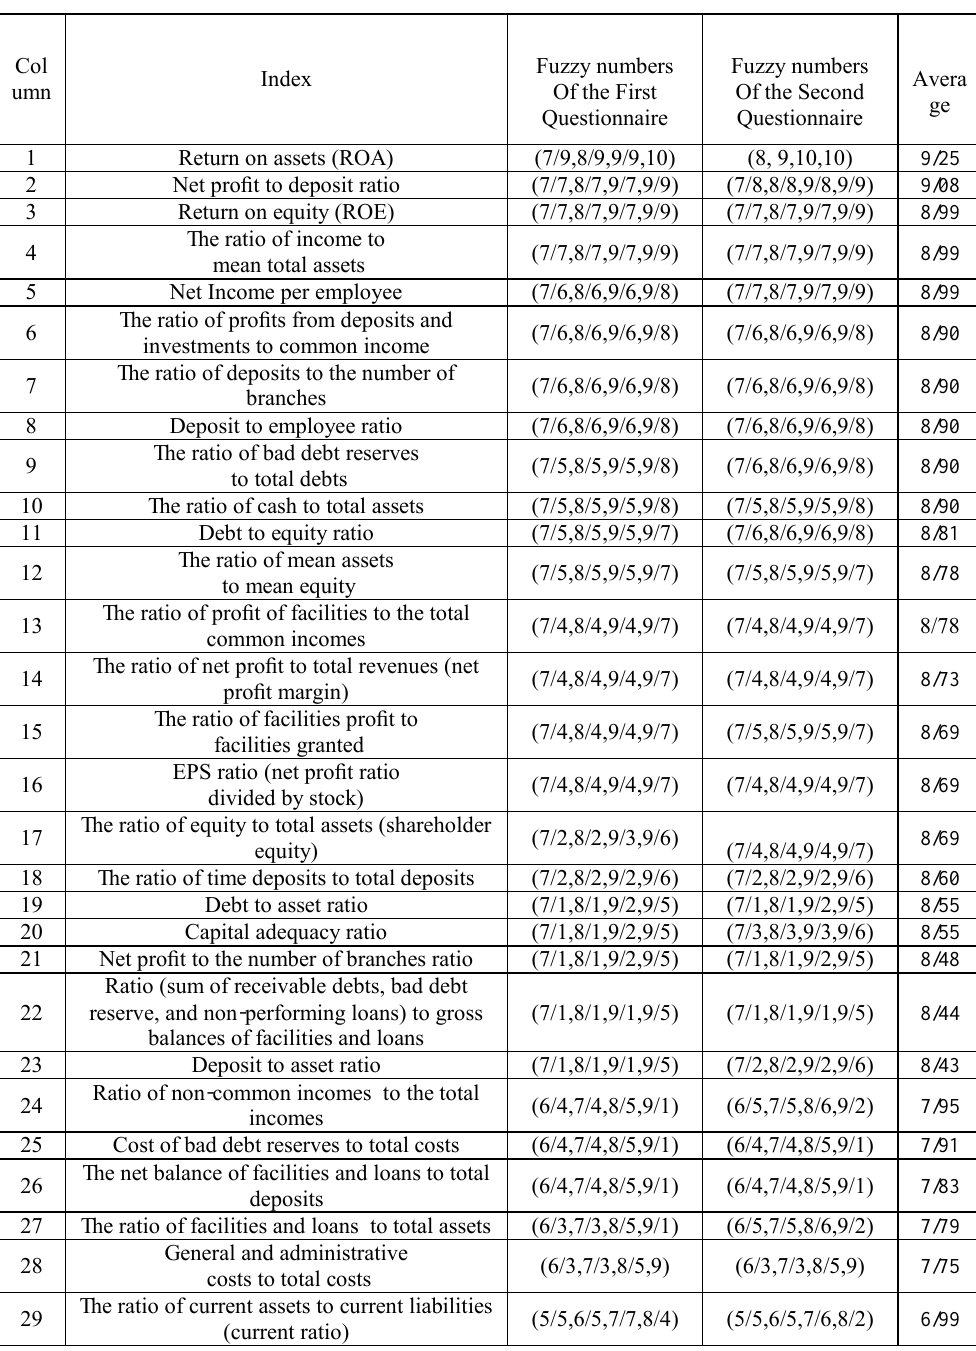
Table 1. Results of the fuzzy Delphi